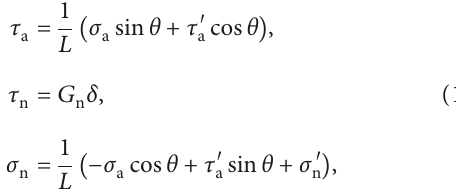
Figure 6: Load-displacement curves for specimen